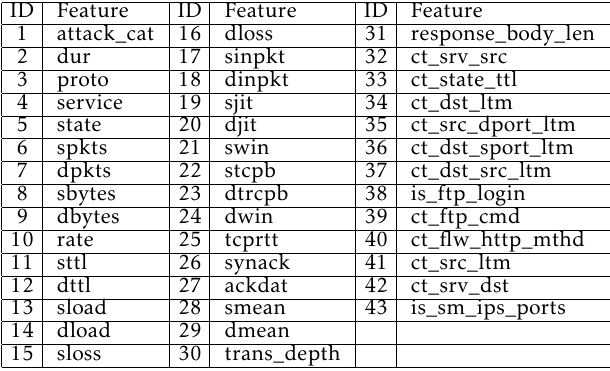
Table 1. The features of UNSW-NB15 dataset.